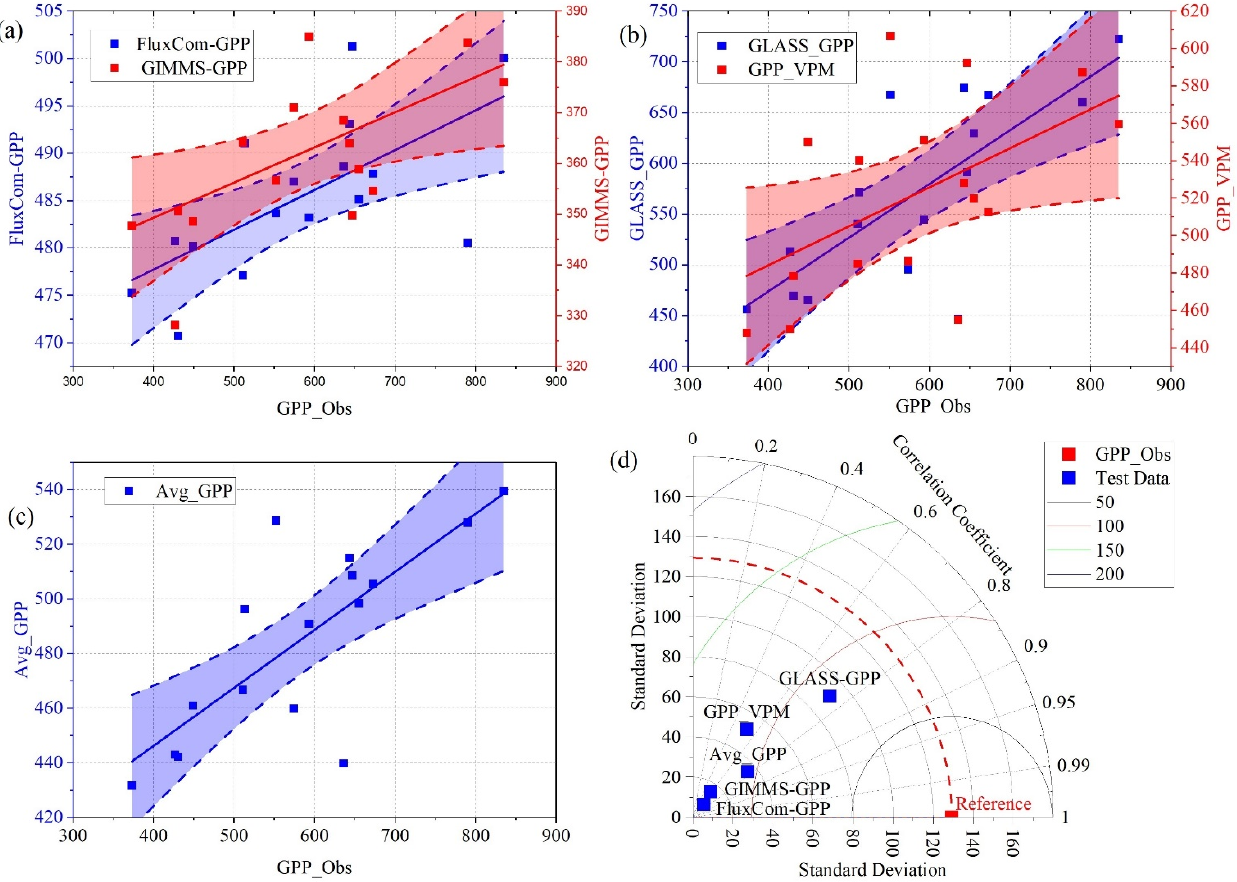
Figure 2. Scatter plots of observed GPP (gCm − 2 yr − 1 ) data against GPP from the four data sets for the period of 2001–2016 and the Taylor diagram evaluation ( a – d ).